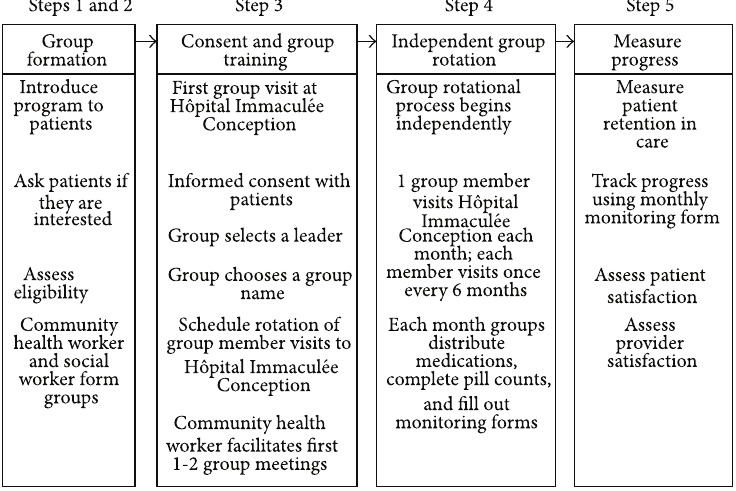
Figure 1: Steps in the Group of 6